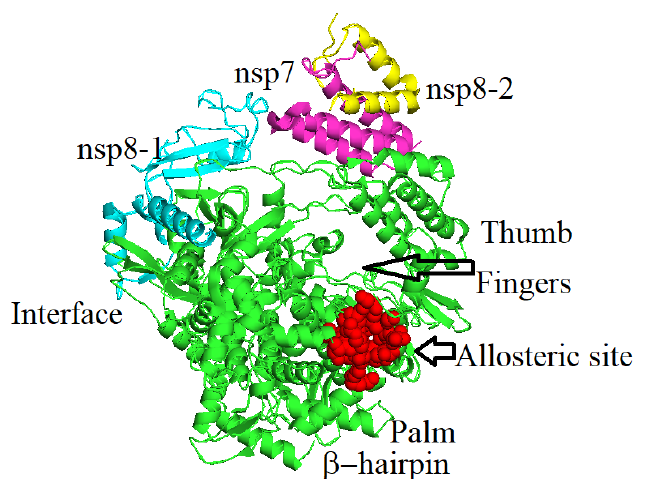
Figure 1. The RNA dependent RNA polymerase of SARS-CoV-2. The red surface shows the iden- tified allosteric site in this enzyme that can be targeted for drug design and inhibition of virus polymerase activity.